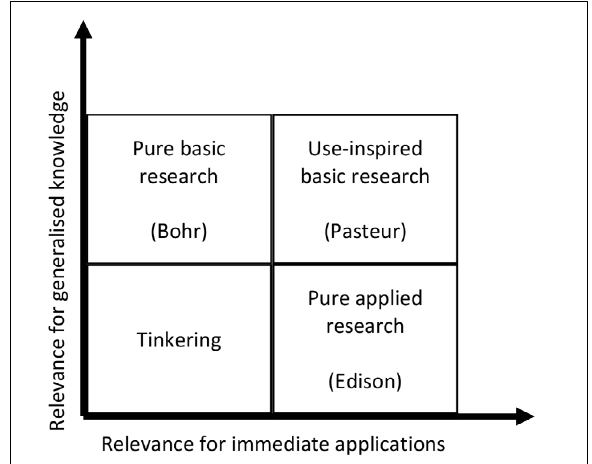
Figure 1: Pasteur’s quadrant (from Stokes 4